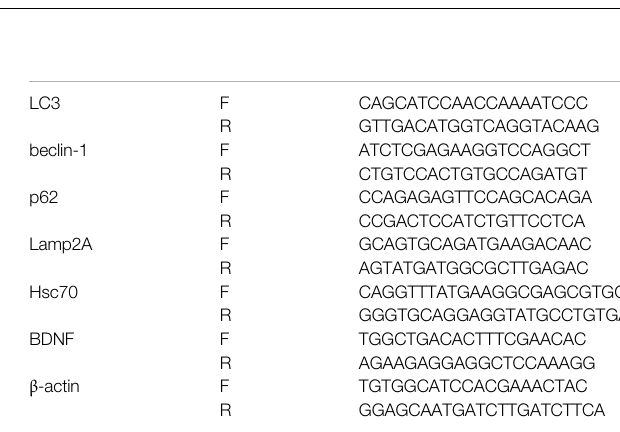
FIGURE 6 | UPLC separation of fractions B was obtained from CCHE and BCHE samples. Base peak extracted chromatograms of fraction B were obtained from CCHE (A) andBCHE (B) .UPLCseparationwasperformedonWatersAcquityPremierHSST3column(100×2.1 mmI.D.,1.8 μ m)applyingalinearelutiongradientfrom 5% to 50% B in 10 min at a fl ow rate of 0.4 ml/min (A: H 2 O, 0.1% formic acid, (B) MeCN, 0.1% formic acid). Retention times were reported on signi fi cant